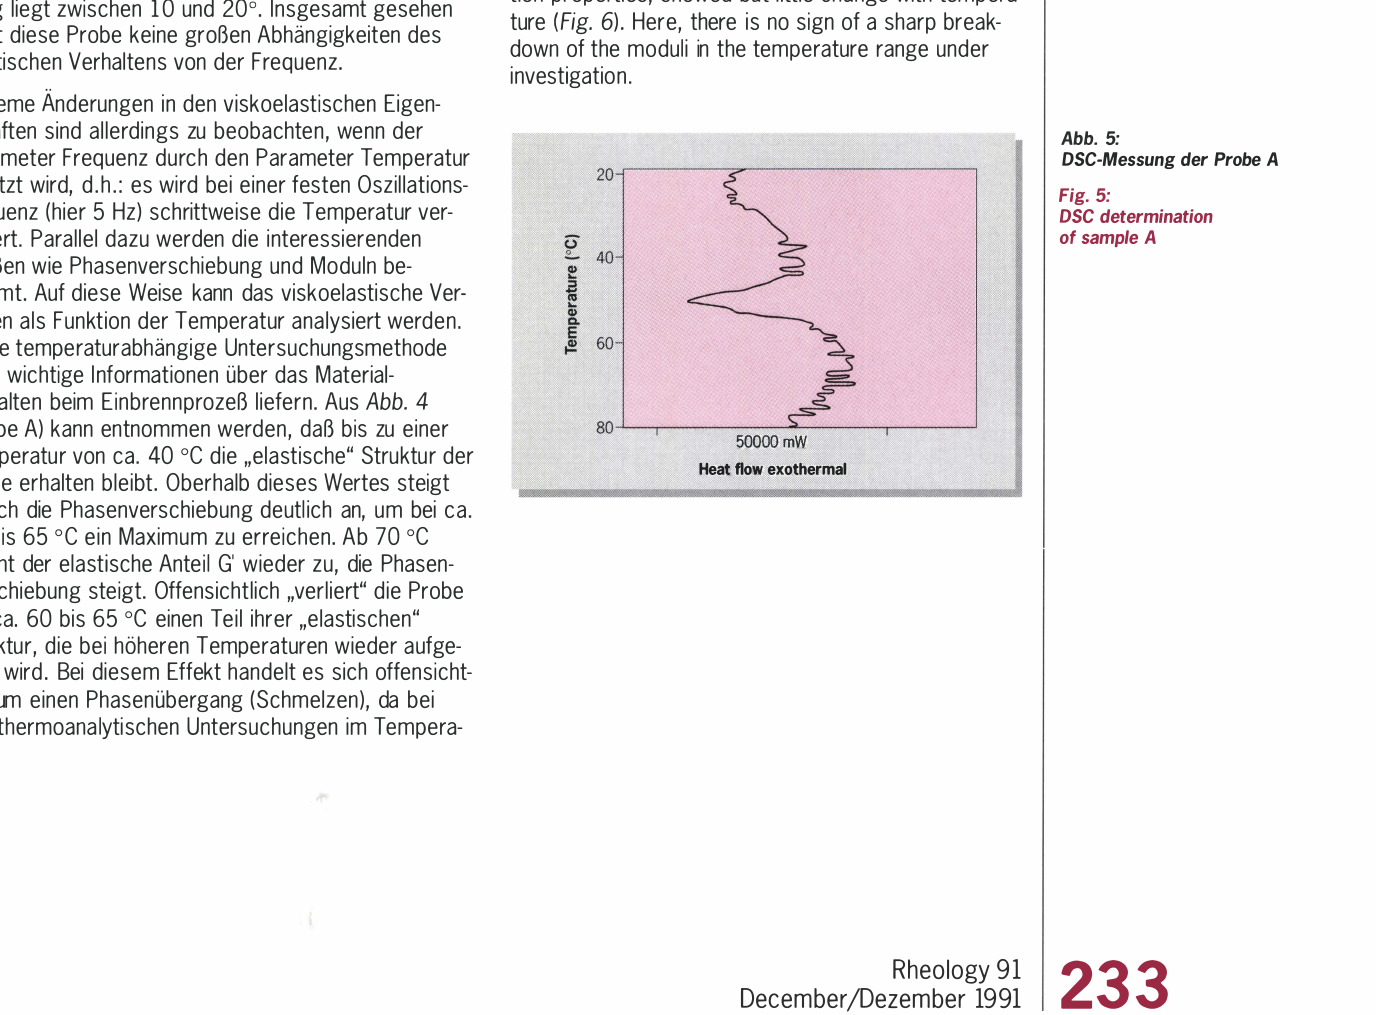
Fig. 5: DSC determination of sample